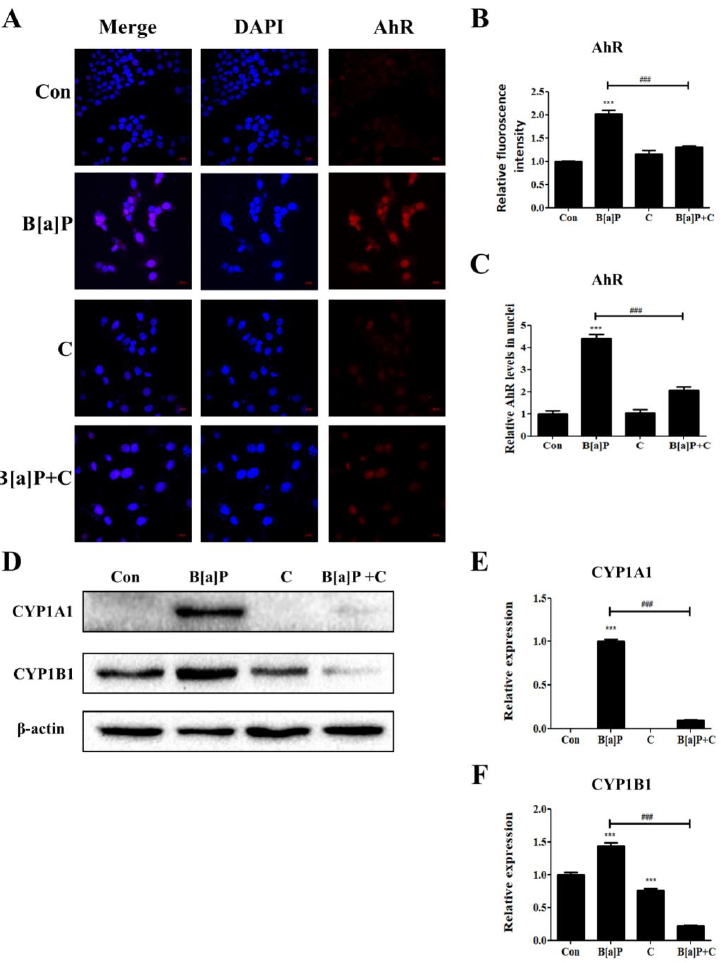
Figure 3. Inhibitory effect of curcumin on B[a]P-induced AhR pathways. ( A ) HepG2 cells were stained for AhR (red). DAPI was used to stain the nuclei (blue). Objective: C-Apochromat 40 ×/ 1.20 W Korr M27. Pinholes: 1 AU for DAPI and AhR. Optical section thickness: 1.2 µm for DAPI and AhR. Modulation of the B[a]P-induced relative fluorescence intensities ( B ) and relative levels of AhR in nuclei ( C ) by curcumin treatment. N = 3 trials per sample and control. ( D ) Effect of curcumin on B[a]P-induced upregulation of CYP1A1 and CYP1B1. Relative expression levels of CYP1A1 ( E ) and CYP1B1 ( F ). N = 3 trials per sample and control. *** p < 0.001, compared with the control; ### p < 0.001, compared with the B[a]P-treated group. Con: control; B[a]P: benzo[a]pyrene (10 µM); C: cur- cumin (10 µM).